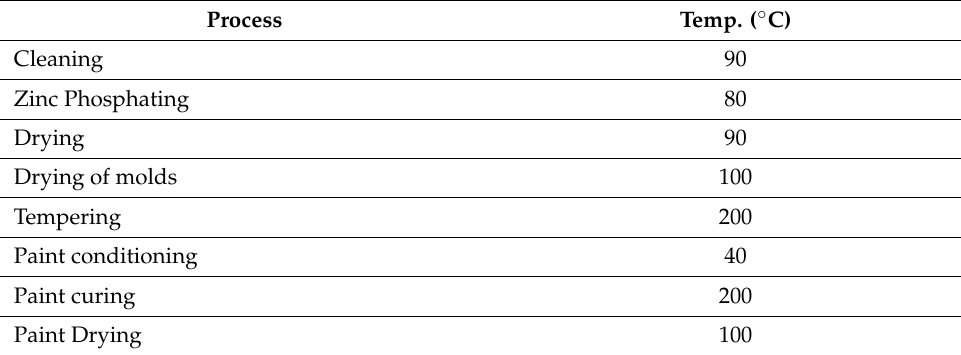
Table 3. Automobile industry process [95,96].